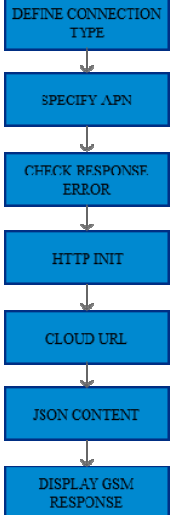
Figure 6. Block diagram of Hyper Text Transfer Protocol (HTTP) initialization.